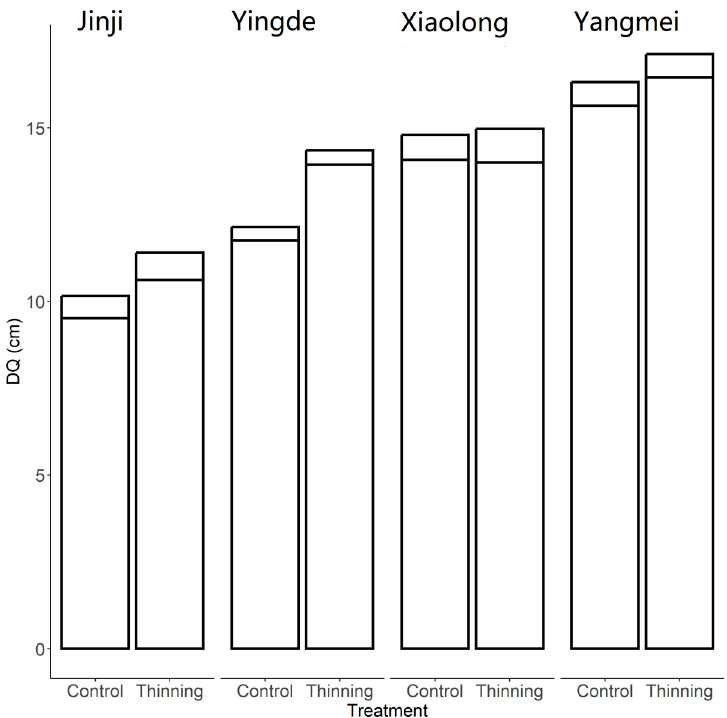
Figure 1. The DBH growth dynamics in the unmanaged plots (control), and thinning plots (thinning) in Yangmei, Jinji, Yingde, and Xiaolong forest farms. The cap of the bar is the mean DBH increment since the treatments applied. Table 2. The quadratic mean stem diameter ( DQ ) ( ± standard errors) of different forest managements in different study sites, in 2020 and 2021. Different lowercase letters indicate significant differences among different study sites in the same year and same treatment; different uppercase letters indicate significant differences between control and thinning in the same forest farm and the same year.